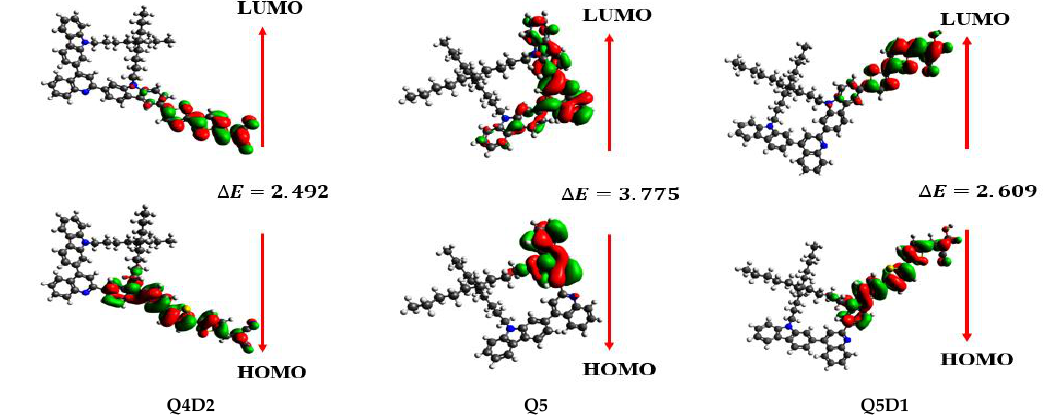
Figure 3 . HOMOs and LUMOs of the studied compounds. Figure 3. HOMOs and LUMOs of the studied compounds.